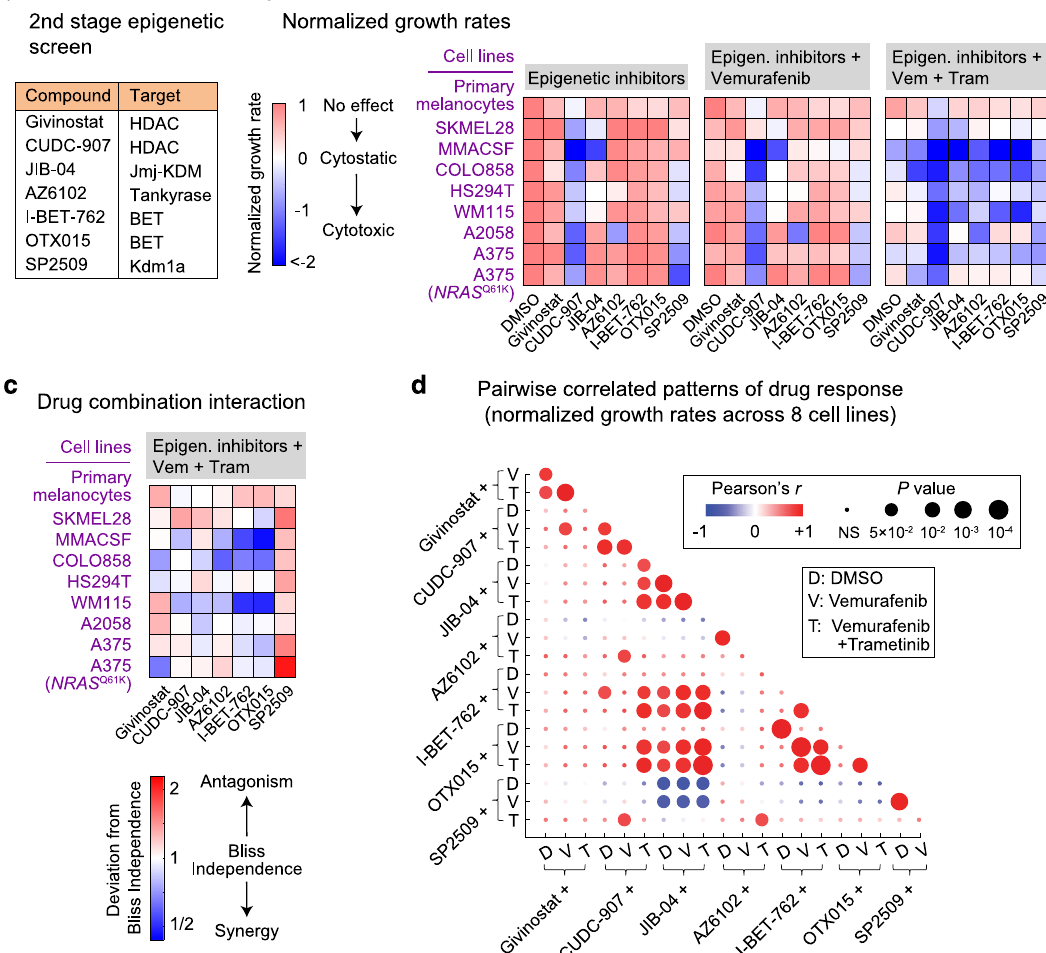
Fig. 3 Patterns of melanoma responses to mechanistically distinct epigenetic inhibitors. a Epigenetic compounds (and their nominal protein targets) used in the second stage of the epigenetic compound screen. b Measurements of normalized growth rate induced by each epigenetic inhibitor, when used either as a single agent (left), in combination with vemurafenib (middle), or in combination with vemurafenib plus trametinib (right), across eight different BRAF -mutant melanoma cell lines and non-transformed primary melanocytes. Treatment doses for different compounds are as follows: Givinostat (200 nM), CUDC-907 (20 nM), JIB-04 (200 nM), AZ6102 (1 μ M), I-BET-762 (1 μ M), OTX015 (0.2 μ M), SP2509 (1 μ M). Cells were pretreated with the indicated epigenetic compounds for 24 h and then treated for a period of 3 – 5 days with either DMSO, vemurafenib (at 100 nM), or the combination of vemurafenib (at 100 nM) and trametinib (at 10 nM). c Deviation from Bliss Independence (DBI) values was computed across diverse epigenetic inhibitor treatments in combination with vemurafenib plus trametinib. DBI = 1 represents an independent (additive) effect equal to what is expected for the combination of drugs that act independently, DBI < 1 represents a combined effect stronger than expected for an independent combination (i.e., synergism), and DBI > 1 represents a combined effect weaker than expected for an independent combination (i.e., antagonism). d Two-sided Pearson ’ s correlation between the effects (i.e., normalized growth rates) of mechanistically distinct epigenetic inhibitors (used individually or in combination with vemurafenib or vemurafenib plus trametinib) evaluated across eight BRAF -mutant melanoma cell lines. Source data are provided as a Source data fi